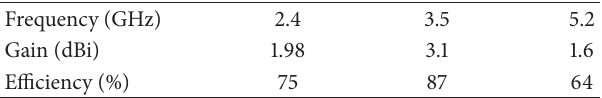
Figure 9: Comparison between simulated and measured scattering parameters for the proposed MIMO array. Table 1: Simulated peak gain and radiation efficiency